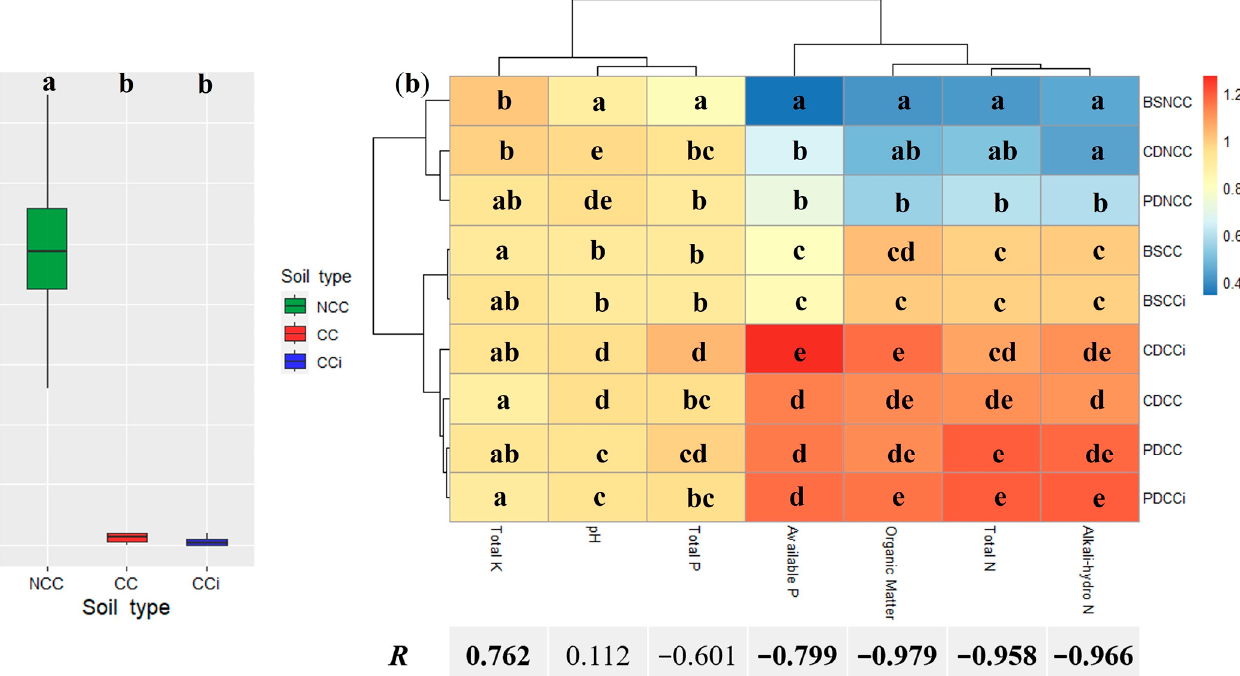
Figure 2. Primordium yield and physicochemical characteristics under different cropping regimes. ( a ) Primordium yield. All values are indicated as the mean ± SE. Bars with different letters represent significant differences among different treatments ( p < 0.05); ( b ) Physicochemical characteristics and their Pearson’s correlation with primordium yield. Data are mean values of n = 4; Lower case letters denote significant differences among different treatments at p < 0.05. Significant correlation coefficients are noted in bold font, where p <